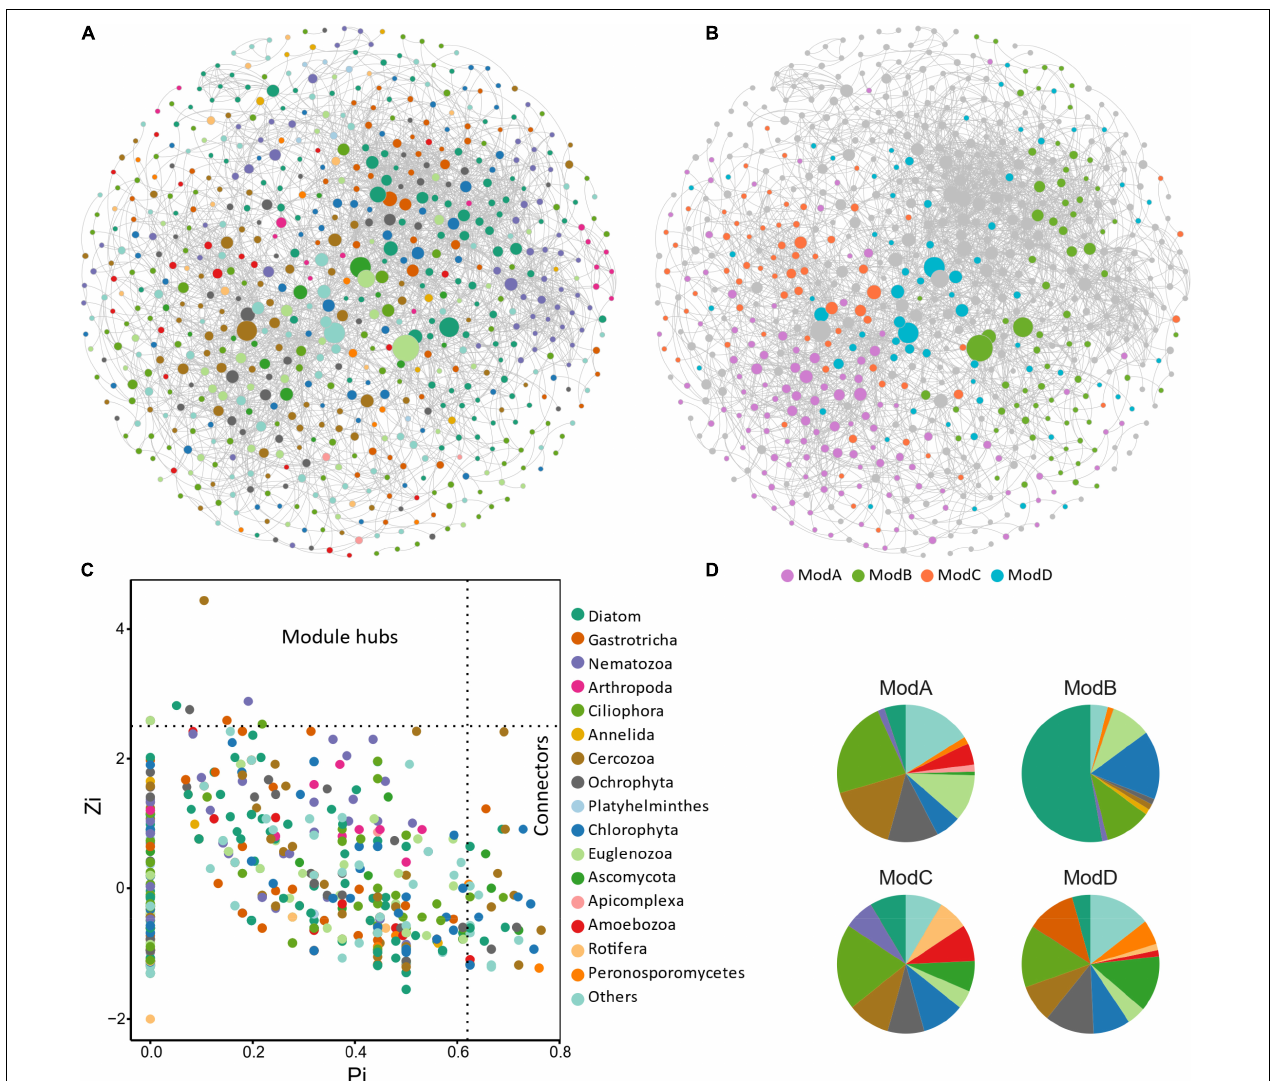
FIGURE 7 | Co-occurrence network and module structure of micro-eukaryotic communities in sediments of the thermokarst lakes. Nodes represent OTUs and are colored by (A) taxonomic groups and (B) major modules (modules contain more than 10% of the nodes). Edges represent strong and significant Spearman’s correlations ( R > 0.5, or R < – 0.5, P < 0.05). P -values were adjusted using the FDR method for false discovery. (C) Topological roles of the nodes in the network. Zi represents within-module connectivity. Pi represents among-module connectivity. Each dot represents an OTU colored by phylum. (D) The taxonomic composition of the major modules shown in number of